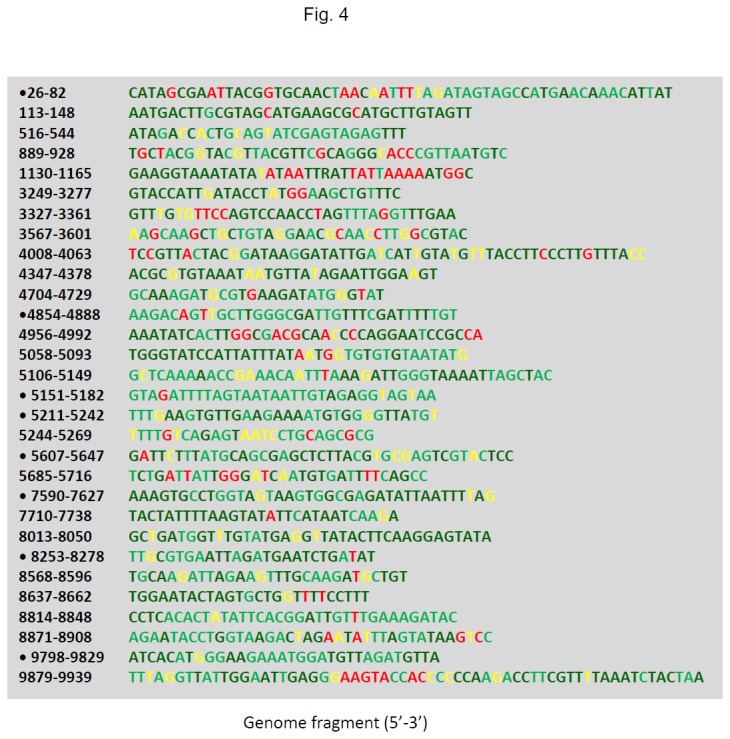
Conserved short fragments (CSF) of the virus population.Between-species conserved regions (consecutively larger than 25 nt, without any SNP) were identified by using sequence alignment of the VDV-1/DWV/KV clade (Figure S5). Within-population SNP was calculated by using the sRNA deep sequencing dataset. Each CSF was labelled using DWV genome positions. Colour coded positions represented within-population mutation rate (Pi) as Pi = 0 (dark green), Pi < 5% (light green), 5% ≤ Pi < 10% (yellow) and Pi ≥ 10% (red). The mutation rate at each nucleotide position was reported in Table S3. Black dots label CSFs with 20 consecutive low Pi sites at the within-population level.